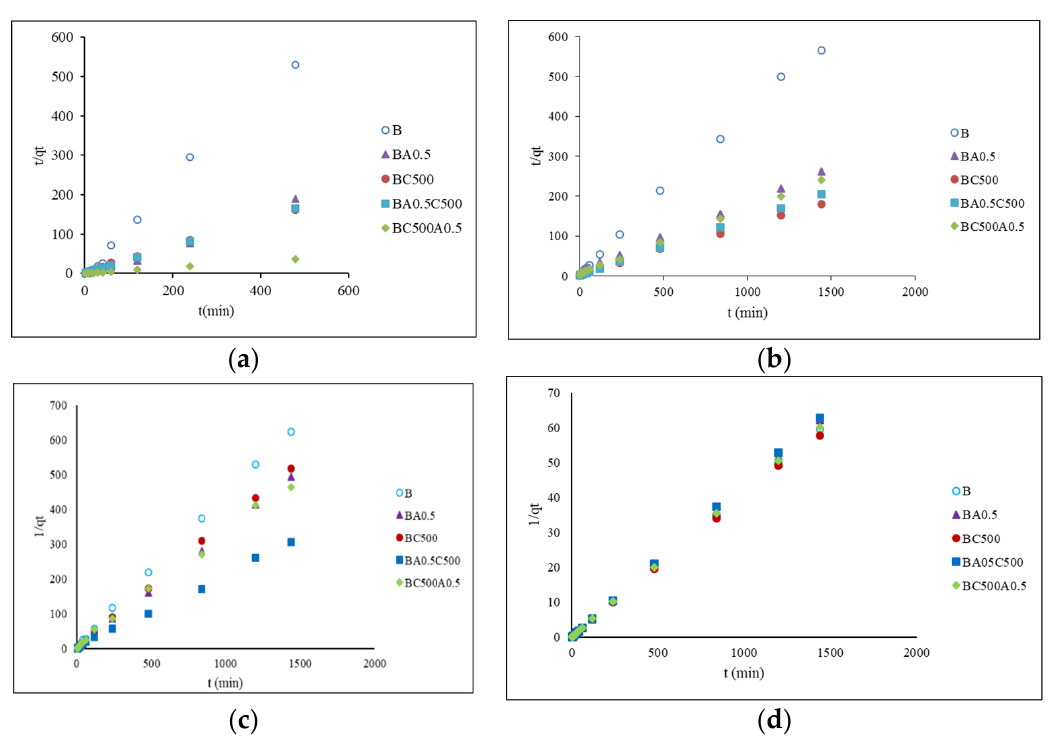
Figure 9. Pseudo - second order plots of atrazine ( a ); diuron ( b ); 2,4 - D ( c ); and paraquat ( d ) adsorp- Figure 9. Pseudo-second order plots of atrazine ( a ); diuron ( b ); 2,4-D ( c ); and paraquat ( d ) adsorption onto bentonite and tion onto bentonite and modified bentonites. modified